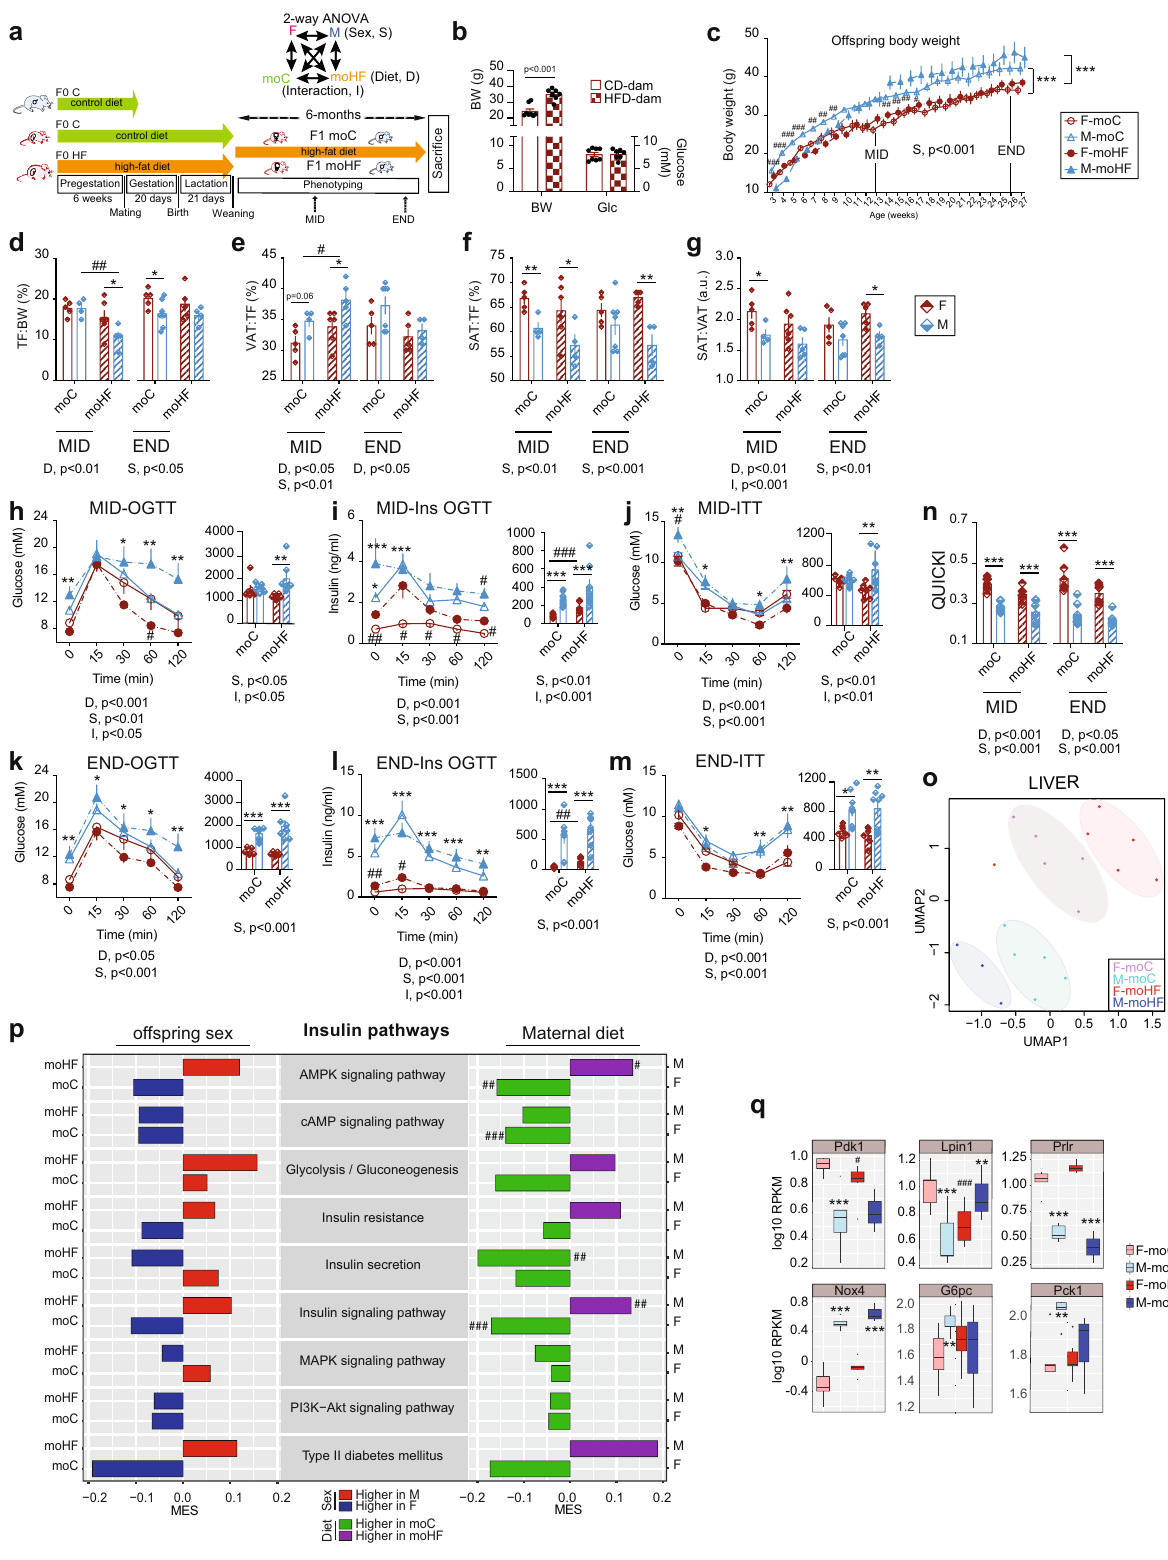
(Fig. S1b). In addition, a large set of genes was differently regulated between sexes in moC but much less in moHF due to the remodeling of gene activity from insulin pathways in females only (Table S1). In sum, females but not males showed reduced insulin- controlled circulating glucose level with MO. However,